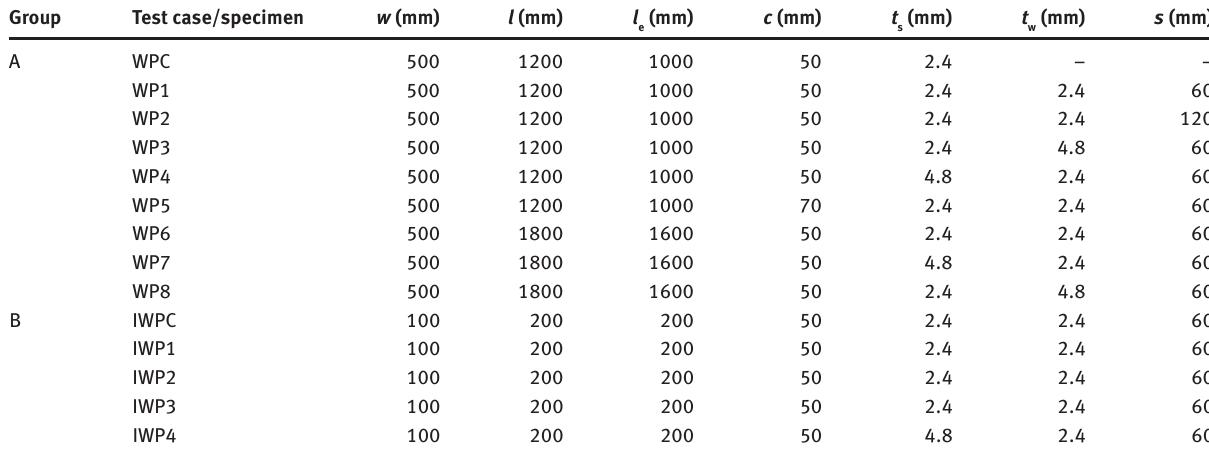
Table 1: Details of specimens.